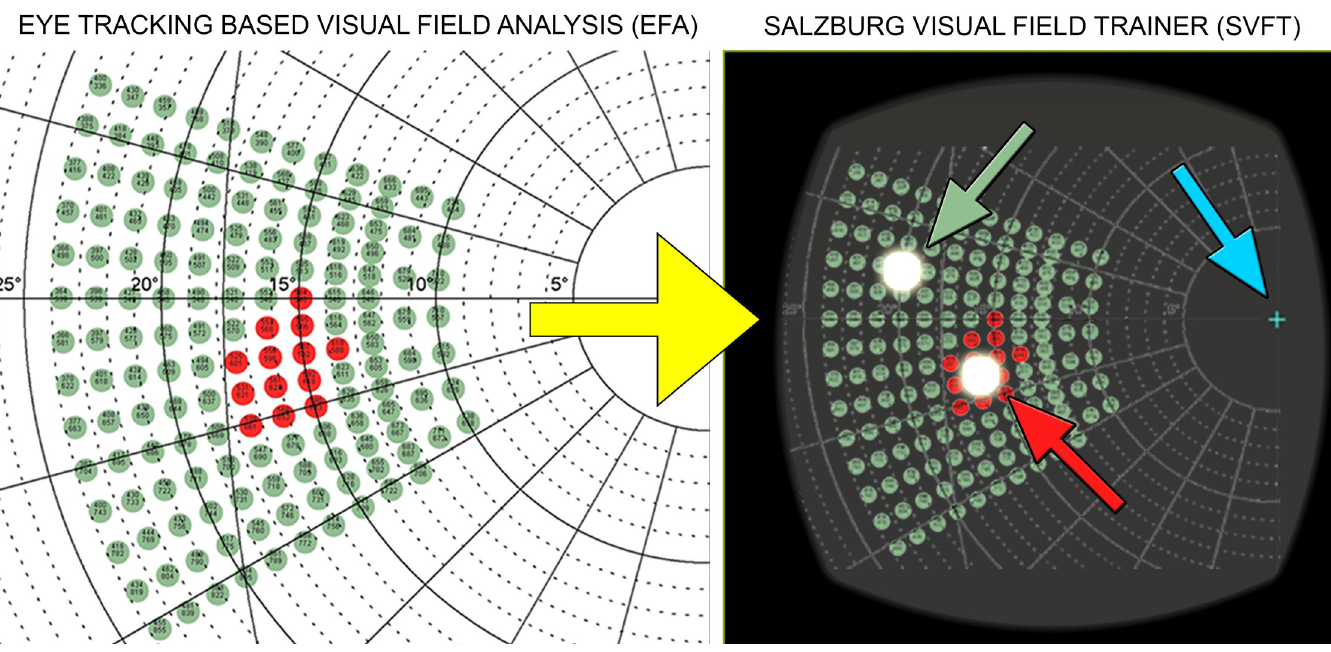
Fig 4. Two-steps experimental design of the study. Left panel (step one): By means of the “Eye Tracking Based Visual Field Analysis” (EFA) the exact individual location and extent of the blind spots (red cluster) of 40 healthy, normal-sighted participants was assessed (illustration shows one exemplary participant). One (red or green) stimulus represents an area of approximately 0.75˚ of visual angle. Right panel (step two): The coordinates of the individual blind spots location and extent were transformed (illustrated by the yellow arrow) into the coordinates system of the “Salzburg Visual Field Trainer” (SVFT). Participants were instructed to keep a steady fixation on the central cross (blue arrow) during testing and press the bluetooth button whenever they saw a stimulus in their peripheral vision. From 100 stimuli that were presented, 15 stimuli were displayed in the individually assessed location of the participants’ blind spots (exemplary “blind spot stimulus”: red arrow) and 85 stimuli were displayed around the participants’ blind spots (exemplary “detectable stimulus”: green